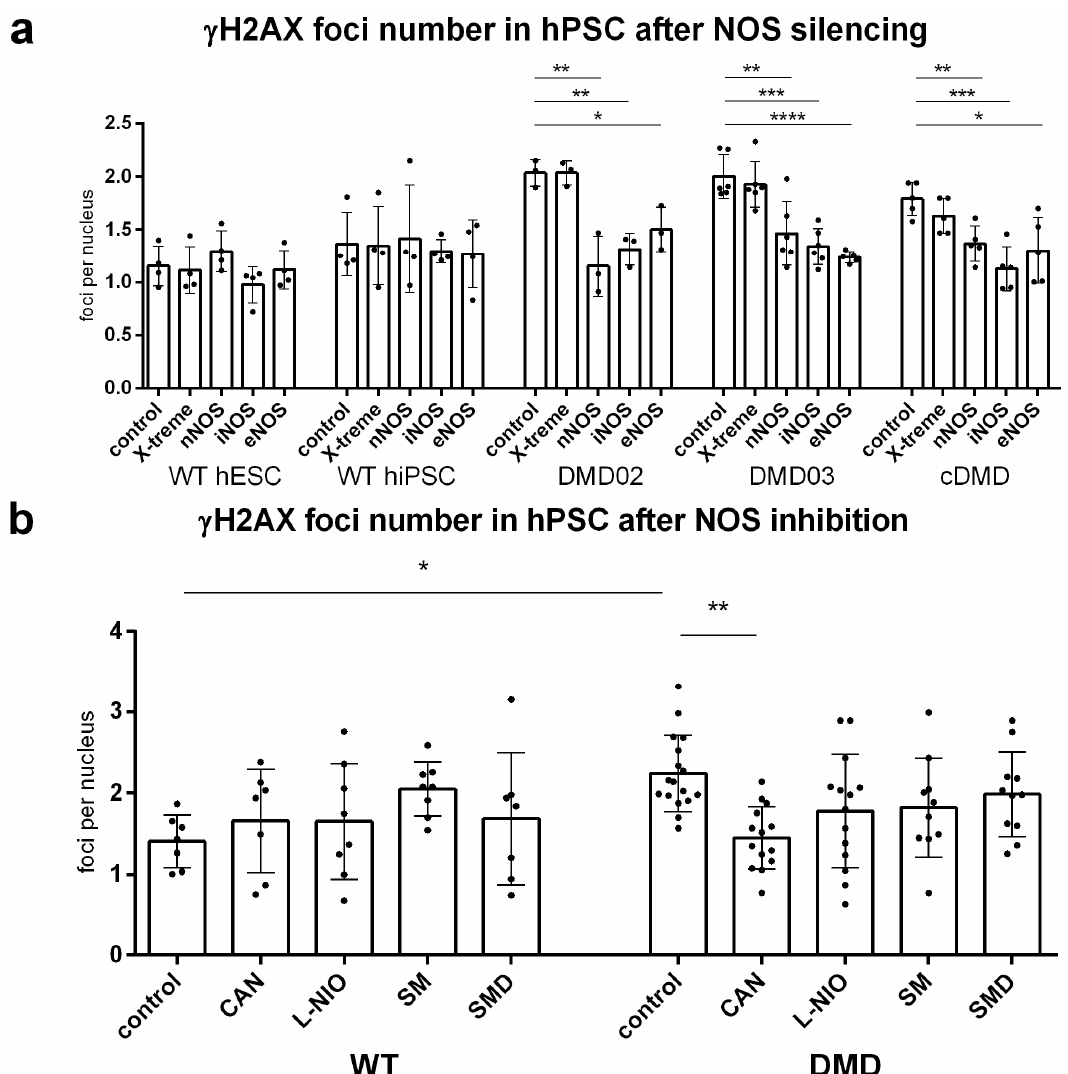
Figure 6. All isoforms of NOS are responsible for increased DNA damage in DMD hPSC. ( a ) DNA damage analysis after downregulation of each individual NOS isoform’s expression show significant decrease in γ H2AX foci formation in DMD hPSC while no significant effect was observed in WT hPSC. Graph shows γ H2AX foci per nucleus for each individual hPSC line in untreated samples (control), after application of transfection reagent (X-treme) and with application of individual siRNA (nNOS, iNOS and eNOS). Statistical difference was evaluated by two-way ANOVA and Tukey’s multiple comparison test using the mutation and treatment presence as evaluation criteria (* p < 0.05, ** p < 0.01, *** p < 0.001, **** p < 0.0001). The error bars represent standard deviation. ( b ) DNA damage analysis after application of specific inhibitors to individual NOS isoforms (CAN = L -canavanine, L -NIO = (N(5)-(1-Iminoethyl)- L -ornithine HCl), SM = spermine, SMD = spermidine) show decreasing trend in γ H2AX foci presence in DMD hPSC. CAN suppressed significantly DNA damage formation in DMD hPSC cell lines while no significant effect was observed in WT hPSC. Graph shows pooled data from WT hESC and hiPSC (WT) and all 3 DMD hPSC lines (DMD). Statistical difference was evaluated by one-way ANOVA and Sidak’s multiple comparisons test; ** p < 0.01, the error bars represent standard deviation. At least 3 biological repetitions were used in each experiment, exact value for each is represented by • in each graph